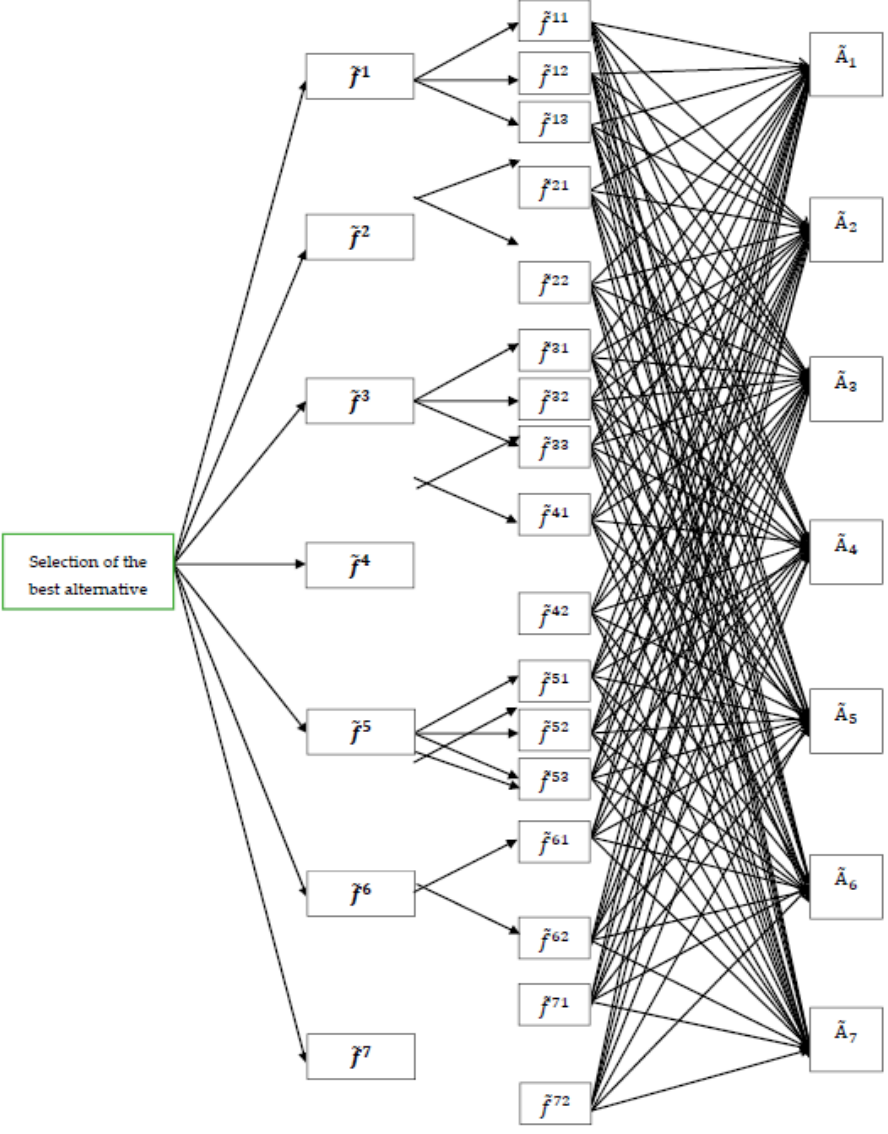
Figure 3. Hierarchical Structure representing the alternatives with factors and sub-factors.